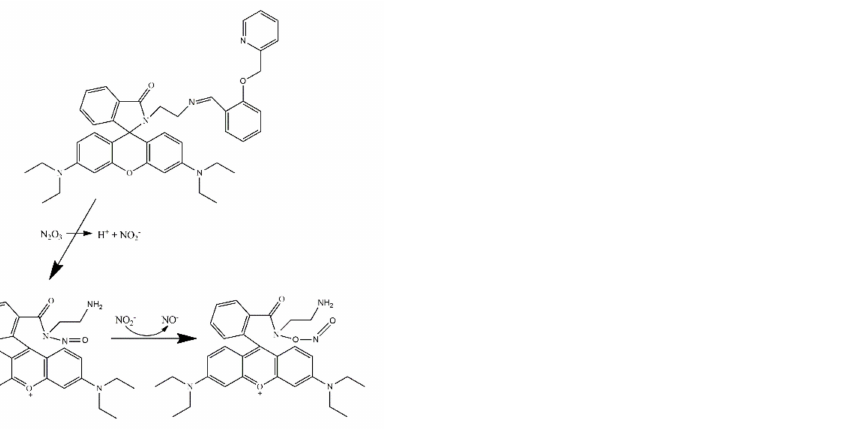
Figure 41. The proposed reaction mechanisms of the prepared sensor (Table 3, No. 2) with NO [91]. Rhodamine-based sensors designed for the detection of 4-dihydronicotinamide ade- nine dinucleotide (NADH), H 2 O 2 (a kind of reactive oxygen species), and adenosine triphosphate (ATP) have gained significant attention in the bioimaging area. Sensor No.3 (Table 3) was synthesized via a redox-responsive 3-aminoquinoline appended rhodamine by Podder A., et al. This sensor was a sort of reaction type fluorescent sensor and showed a remarkably increasing fluorescent intensity in the presence of NADH [92]. Apart from the common detection function, the sensor (MQR) figured out the connection between NADH levels and metabolic abnormalities of high clinical significance (Figure 42).